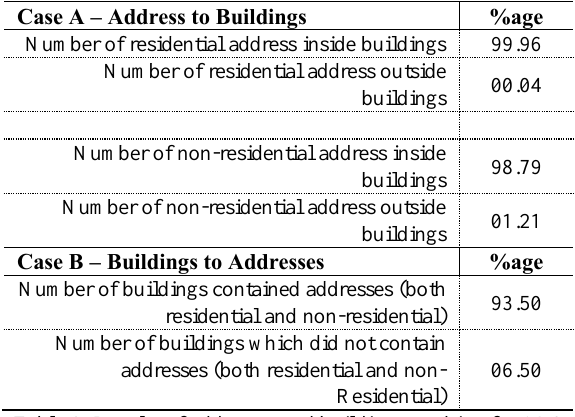
Table 9. Results of addresses and building matching for AL2